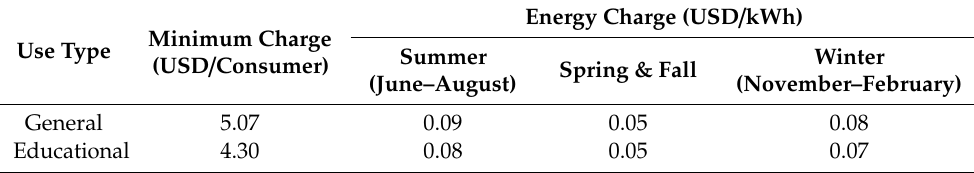
Table 8. Electricity tari ff s for low voltage general and educational